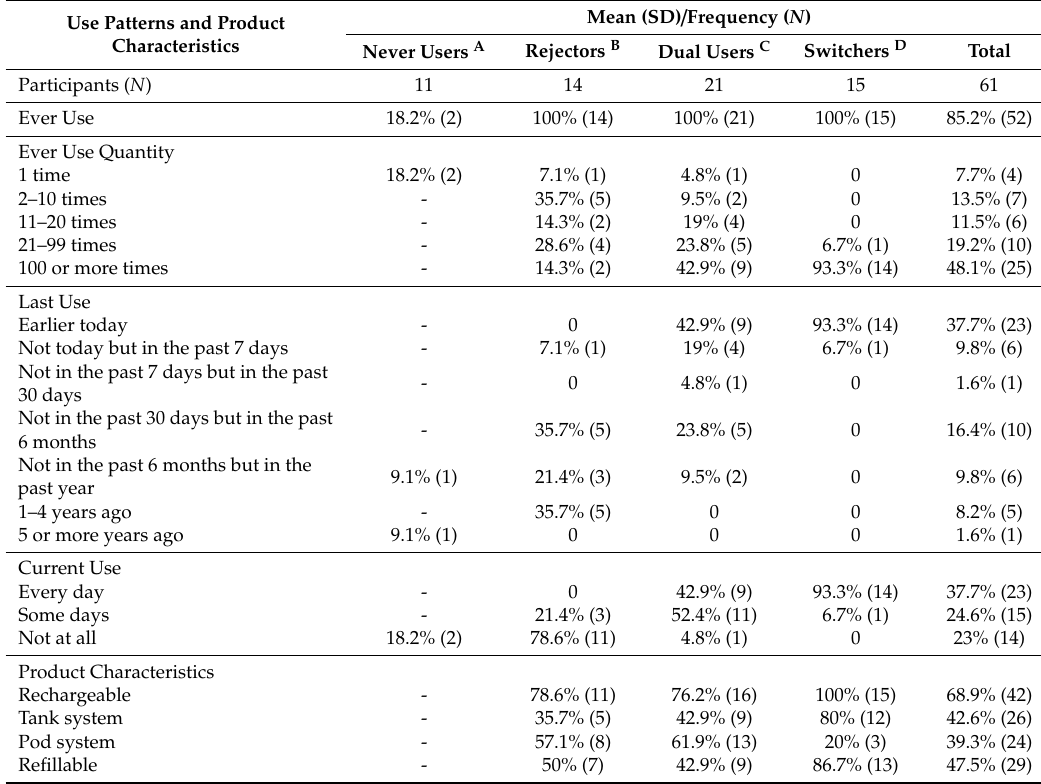
Table 2. ENDS use patterns and product characteristics from the pre-focus group